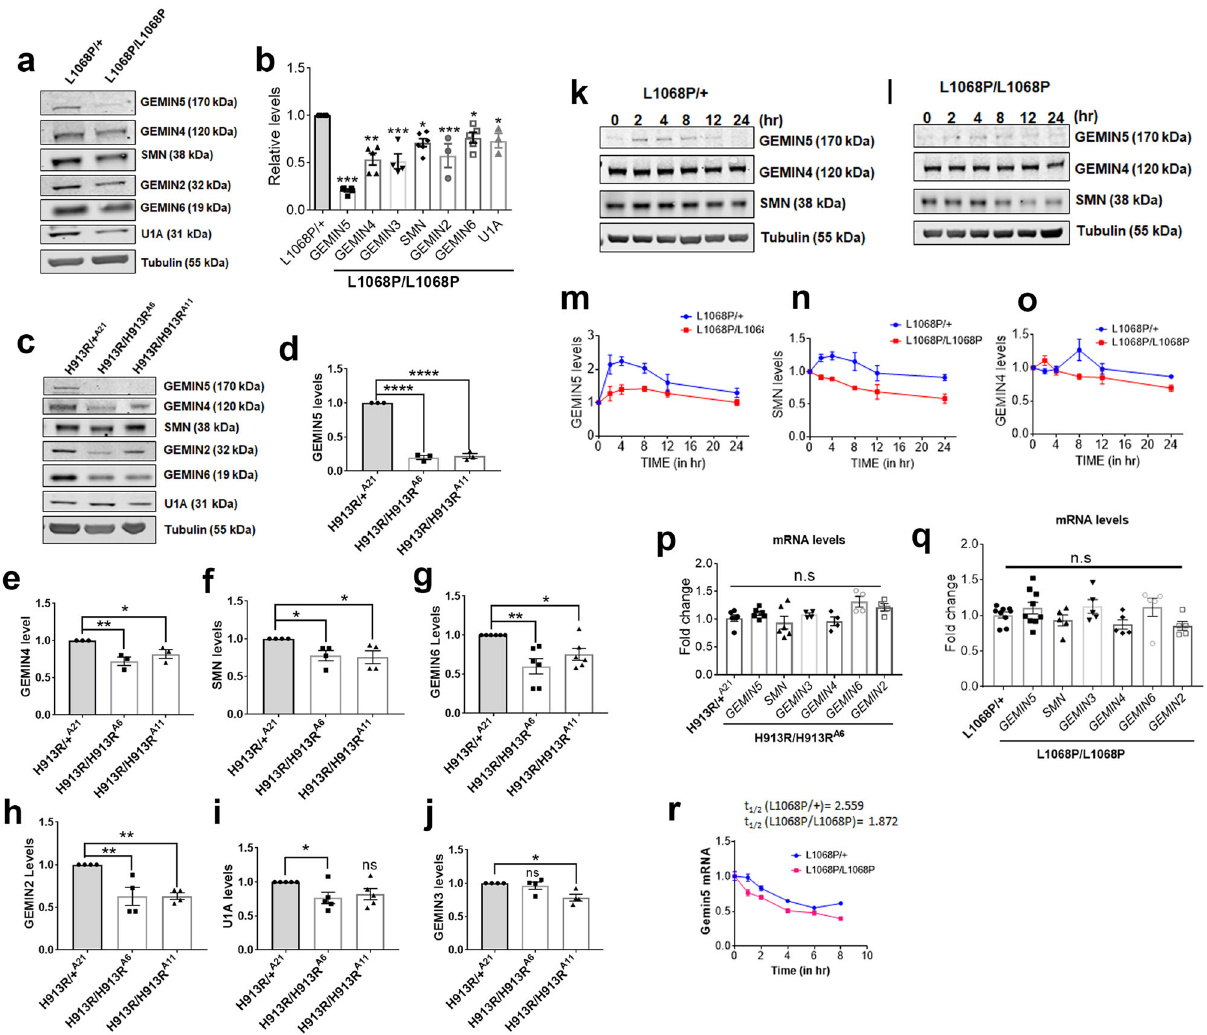
Fig. 3 GEMIN5 variants reduce the levels of GEMIN5 and SMN assembly proteins. a Western blot (WB) analysis of total protein extract from IPSC- derived neuronal cells carrying mono-allelic and bi-allelic L1068P GEMIN5 variants depicting the levels of GEMIN5, GEMIN4, GEMIN6, and GEMIN2, SMN, and U1A, respectively . b Quantitative bar plots showing the reduced levels of GEMIN5 and SMN assembly proteins in L1068P homozygous neurons compared to heterozygous controls (two-tailed unpaired t test, n = 4). c Representative WB depicting the expression levels of GEMIN5 and SMN complex proteins in heterozygous and homozygous H913R neurons d – j , Quantitative comparison of expression levels of GEMIN5 ( d ), GEMIN4 ( e ), SMN ( f ), GEMIN6 ( g ), GEMIN2 ( h ), U1A ( i ), and GEMIN3 ( j ) between H913R − / − and H913R + / − neuronal cells as in ( d ) (one-way ANOVA-Bonferroni test, n = 4). k , l Representative WB showing the protein levels of GEMIN5, GEMIN4, and SMN in L1068P heterozygous ( k ) and homozygous ( l ) neurons after 0, 2, 4, 8, 12, and 24h of cycloheximide (CHX) treatment. Tubulin was used as normalization control. m – o Quantitative analysis of the rate of degradation of GEMIN5 ( m ), SMN ( n ), and GEMIN4 ( o ) after CHX treatment showed the increased rate of depletion of GEMIN5 and SMN in homozygous L1068P neurons as compared to heterozygous controls (nonlinear regression-one phase decay, n = 4). p , q Expression analysis of GEMIN5, SMN, and other GEM- proteins by qPCR in L1068P ( p ) and H913R ( q ) neurons. The transcript levels of GEMIN5, GEMIN4, GEMIN3, GEMIN6, GEMIN2, and SMN showed no signi fi cant changes among heterozygous and homozygous GEMIN5, L1068P, and H193R variants (two tailed Mann – Whitney U test, n = 6). r Quantitative PCR showing the relative stability of GEMIN5 mRNA between hetero and homozygous L1068P neurons by using total RNA isolated at 0, 1, 2, 4, 6, and 8 h after actinomycin D treatment (nonlinear regression-one phase decay, n = 4). The data represent mean ± SEM. P values (****<0.0001, ***<0.001, **<0.01). Source data are provided as a Source Data fi